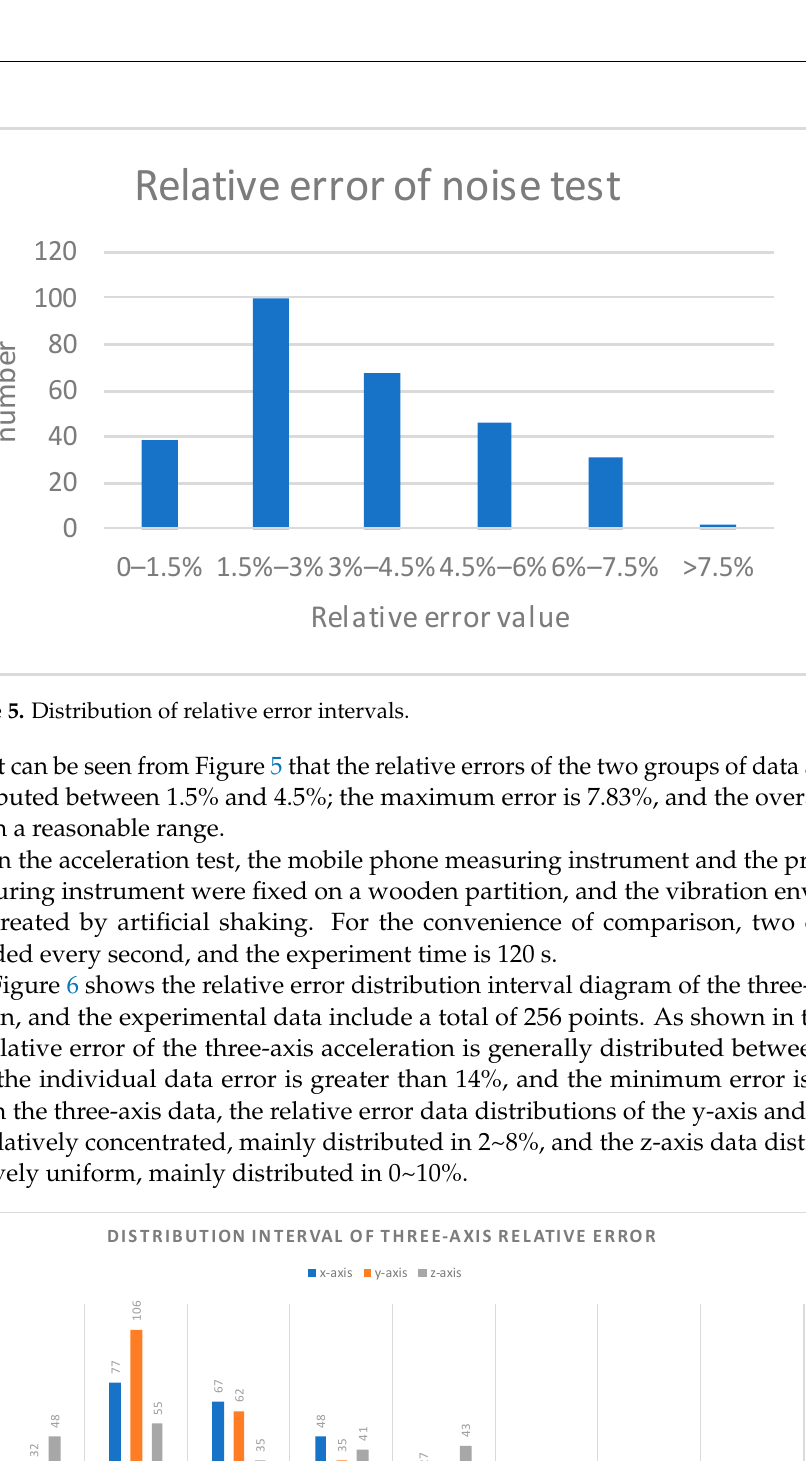
Table 2. Comparison of Sperling index values of mobile phone/professional instrument.